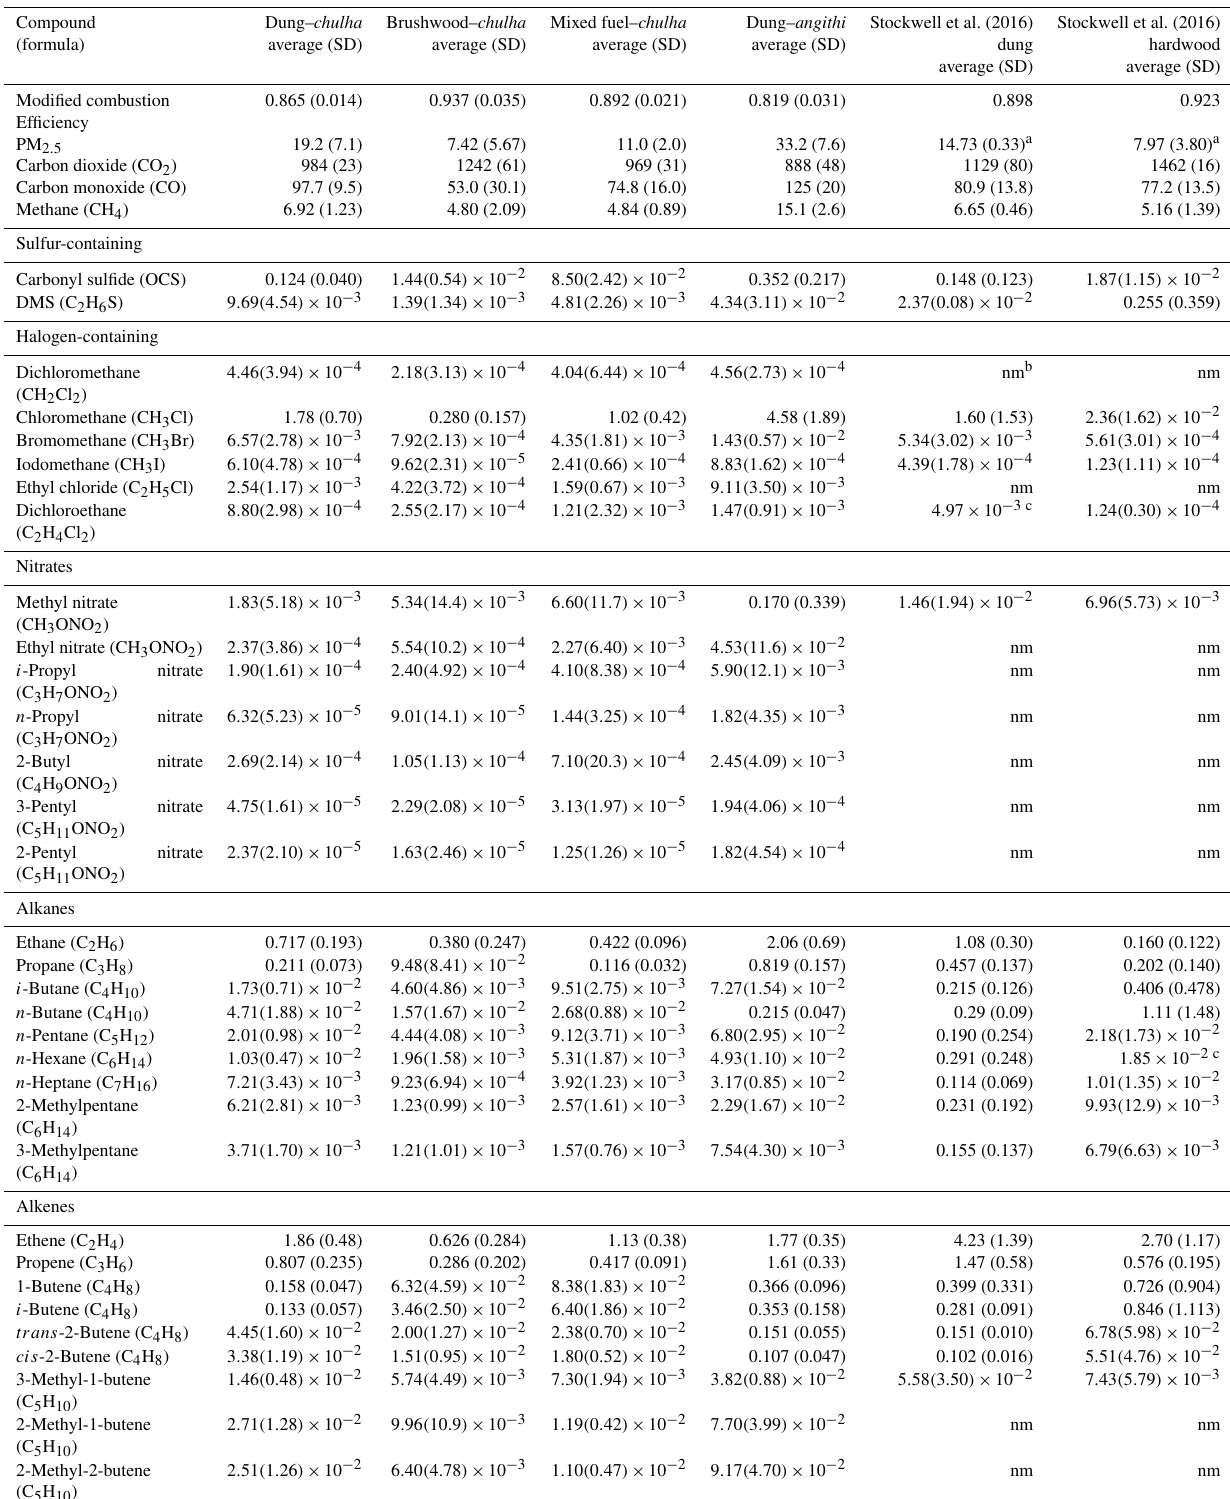
Table 1. Averaged emission factors and standard deviation of PM 2 . 5 and gas-phase species (gkg − 1 dry fuel) for dung– chulha , brushwood– chulha , mixed fuel– chulha , and dung– angithi cook fires. Previously published emission factors (gkg − 1 dry fuel) from dung and hardwood cook fires are shown for comparison (Stockwell et al., 2016). Sample sizes for the current study ( n ) were n = 18 for dung– chulha , n = 14 for brushwood– chulha , n = 13 for mixed- chulha , and n = 10 for dung– angithi .